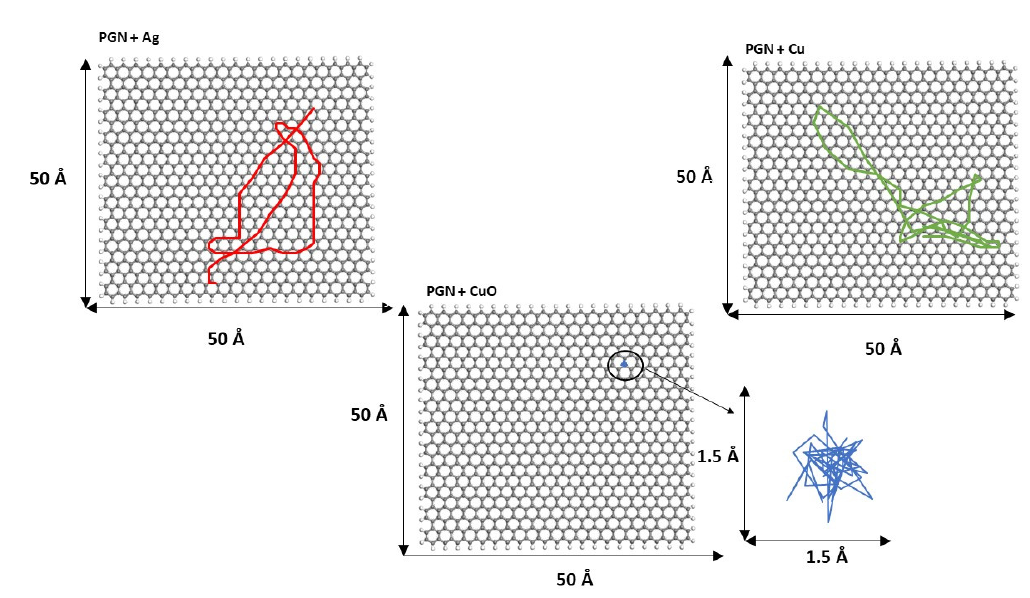
Figure 9. Diffusion trajectories of Ag 13 , Cu 13 , and Cu 6 O 6 over PGN during the last 250 ps of simulation length. The diffusion trajectory of the Cu 6 O 6 cluster is magnified for a clearer view.